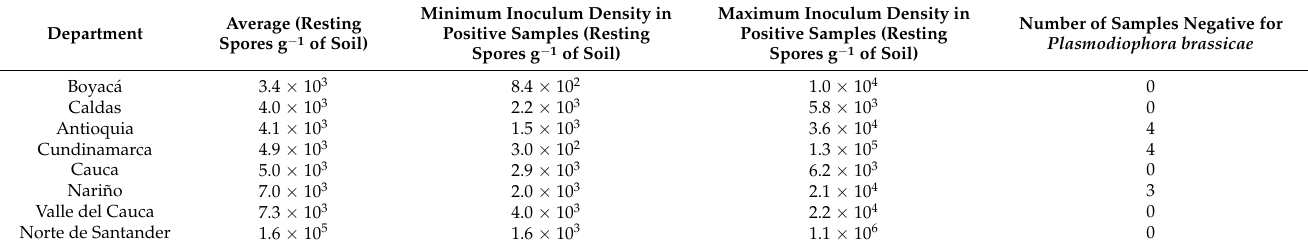
Table 3. Average, minimum, and maximum inoculum densities in 127 soil samples collected from the main regions producing cruciferous crops in Colombia in